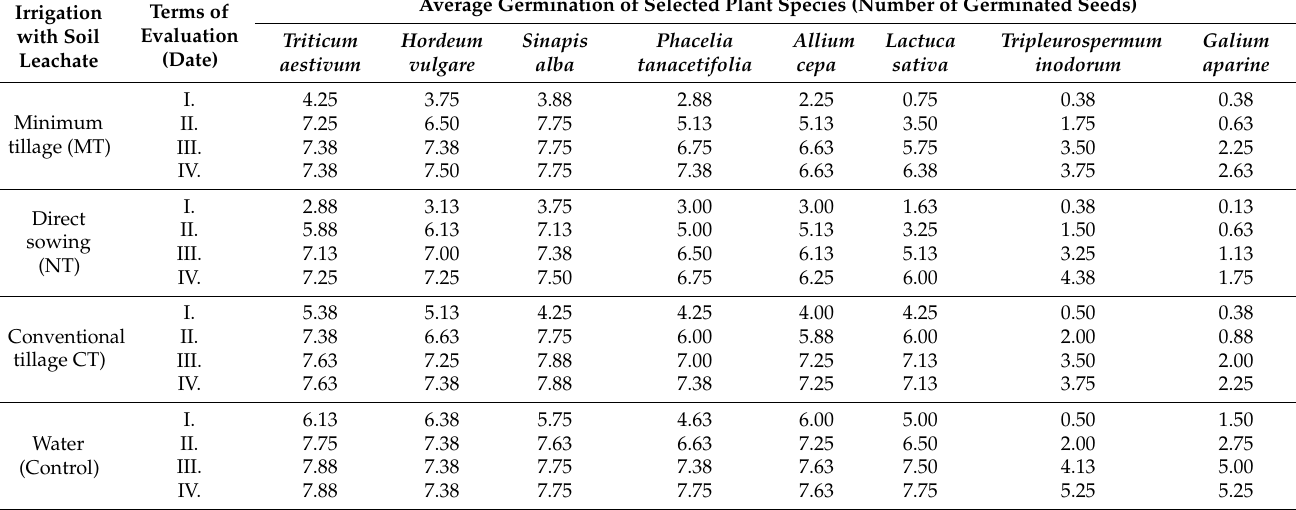
Table 1. Average germination of studied plant species.